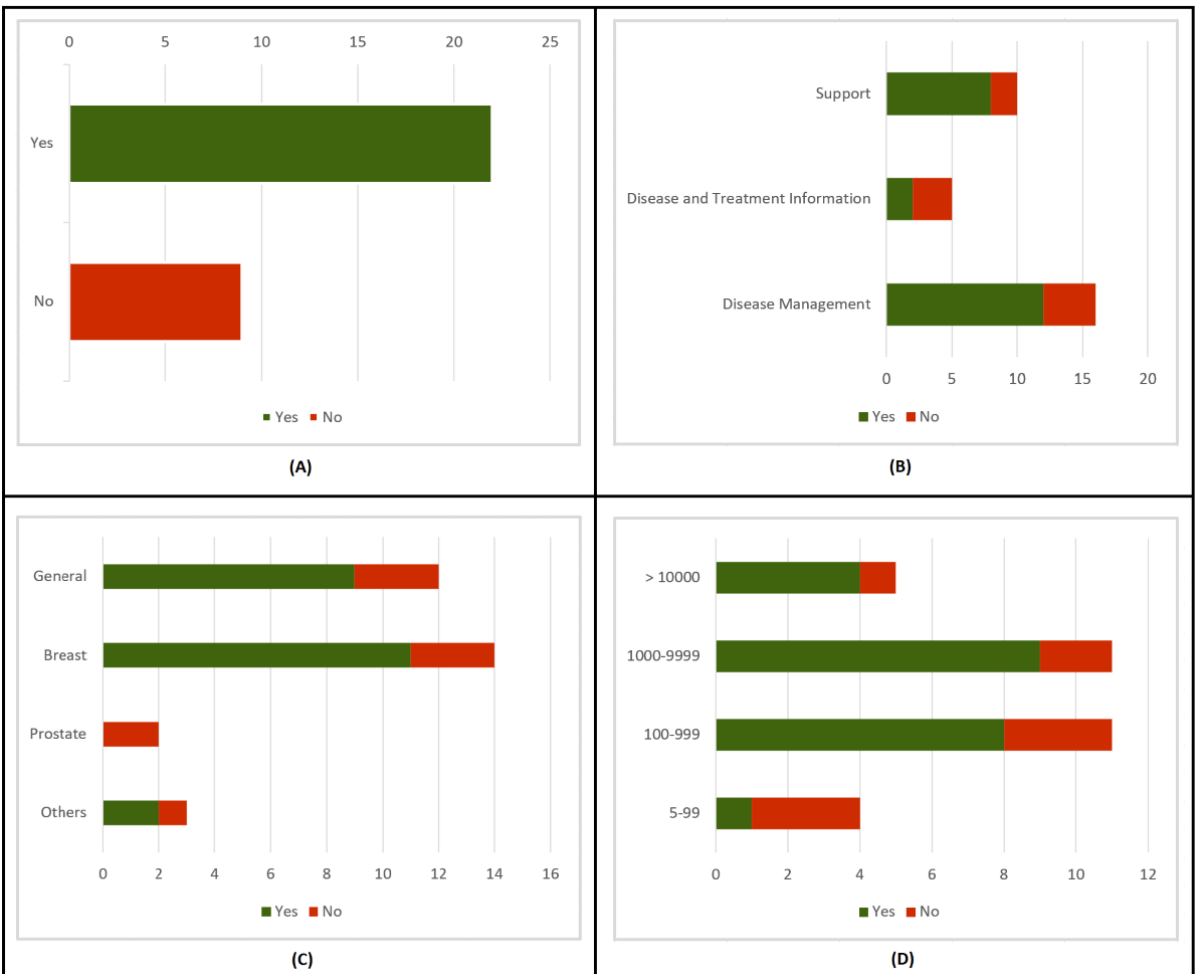
Figure 2. Analysis of privacy policy